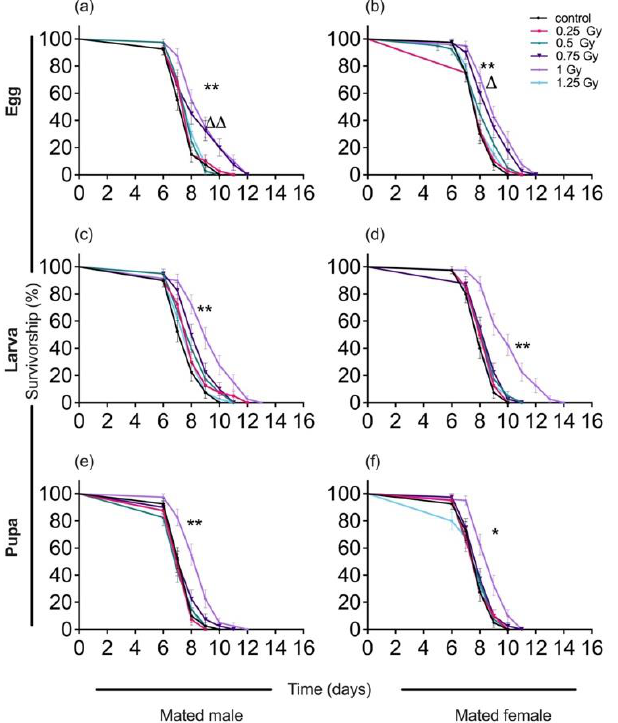
Figure 2. Survivorship curves of mated adult male and female Spodoptera litura exposed to low-dose ionizing radiation (LDIR) in different ontogenetic (Egg, Larva, Pupa) stages. ( a ) Male, ( b ) Female moths, irradiated in egg stage; ( c ) Male, ( d ) Female moths, irradiated in larval stage; ( e ) Male, ( f ) Female moths, irradiated in pupal stage. Significant difference between survival curves was conducted using a log-rank (Mantel-Cox) test for each condition, and significance is denoted by triangles in 0.75 Gy and asterisks in 1.0 Gy. ( ∆ p < 0.05, ∆∆ p < 0.001 level; * p < 0.05 level, ** p < 0.001